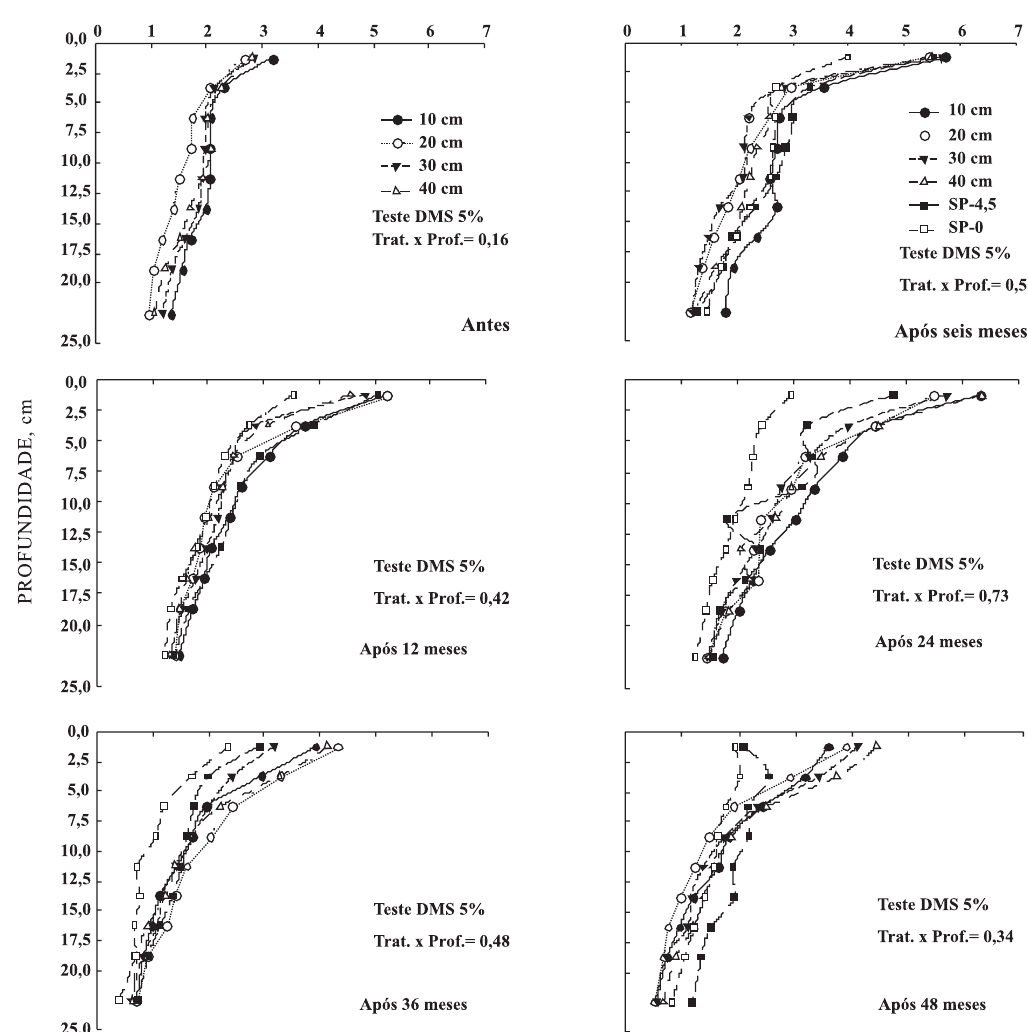
Figura 3. Teor de magnésio trocável em diferentes épocas da aplicação superficial de calcário em Latossolo Vermelho, sob sistema plantio direto e integração lavoura-pecuária, com diferentes pressões de pastejo no